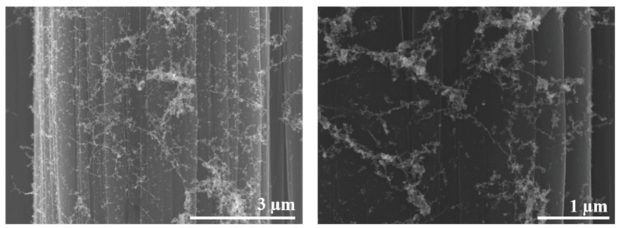
Figure 6. SWCNTs network on desized carbon fibres at low nodular growth rate. As the deposition temperature increases, the nodules become larger and turn into clusters. The micrographs in Figure 7 reveal the effect of the deposition temperature. Low temperature resulted in uneven deposition with few desized fibres being coated, yet finer CNT nodules, 100 nm and less. Higher temperatures led to the formation of larger CNT nodules or clusters, in the order of 0.5 µ m.